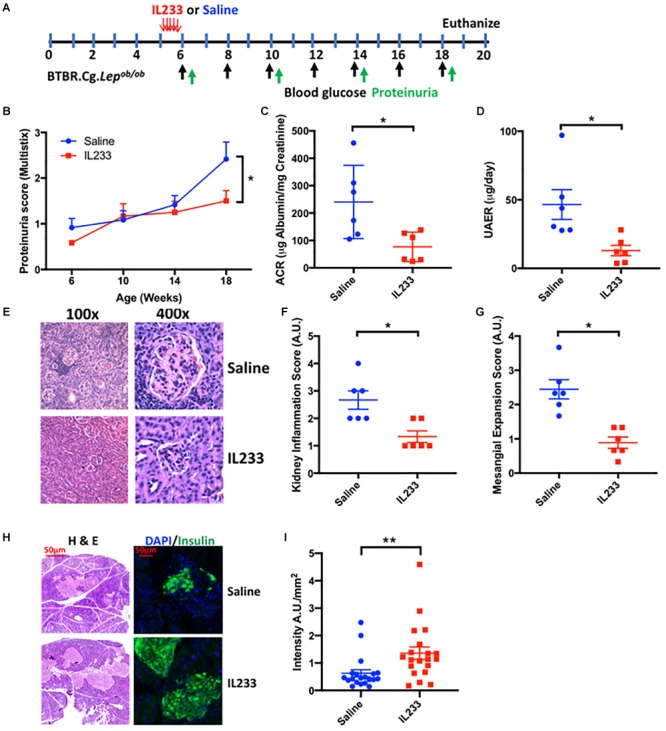
One time IL233 induction therapy of young mice offers long-term protection from loss of renal as well as pancreatic structure and function. (A) Experimental design; BTBR.Cg-Lepob/ob mice (5 weeks old) were injected with saline or IL233 for 5 consecutive days and followed over time for proteinuria using urinalysis MultistixTM
(B). (C) Urinary albumin creatinine ratio (ACR) and (D) Urinary albumin excretion rate (UAER) was measured at necropsy. (E) Representative kidney section using low and high power objectives. Quantification of kidney inflammation (F) and mesangial expansion (G) was performed according to the criteria mention in the Section “Materials and Methods.” (H) Representative hematoxylin and eosin (H&E) and immunofluorescence staining for insulin. (I) Quantification of insulin/mm2 area of islets. Data is compiled from two independent experiments. Mean ± SEM is shown (n = 6). Symbols represent individual mice; ∗p < 0.05; ∗∗p < 0.01; by non-parametric t-test and two-way ANOVA with repeated measures for (B).